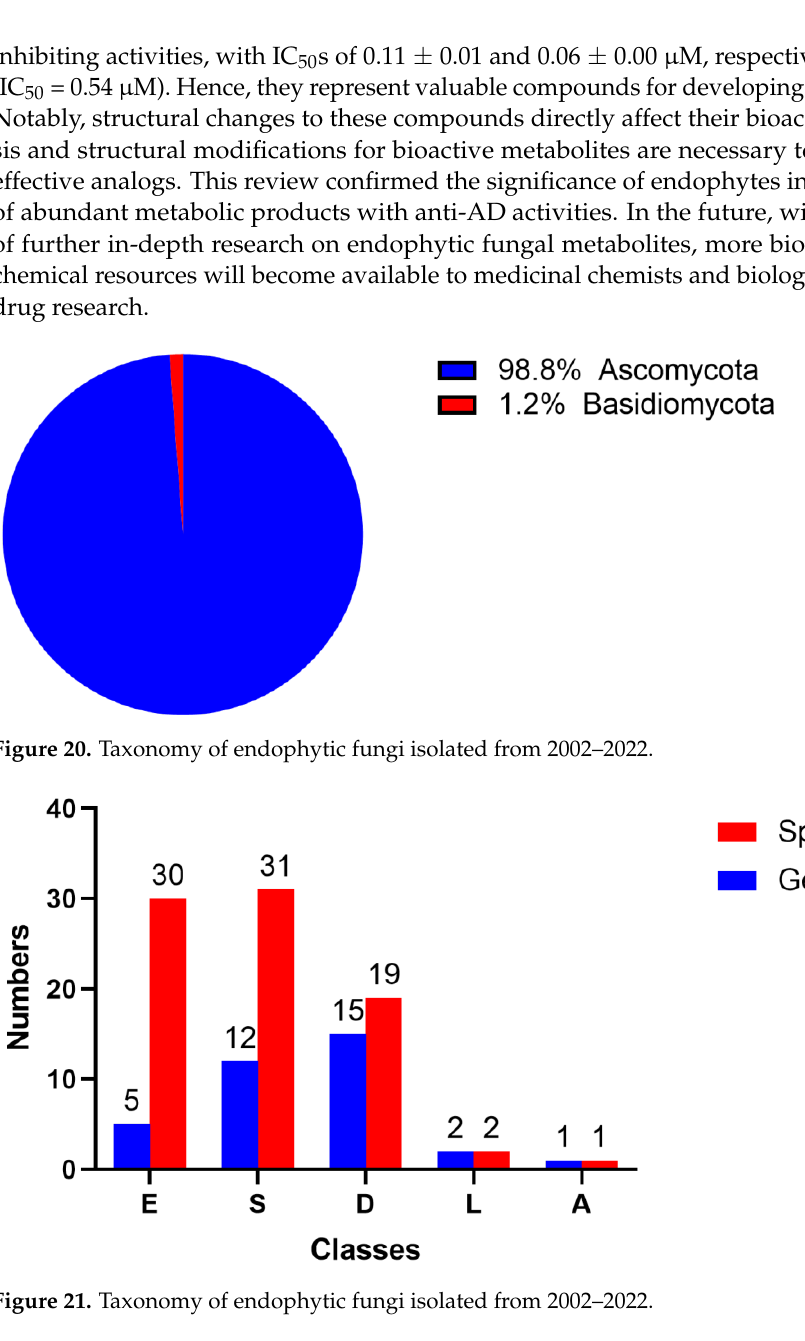
Table S3: Polyketides from endophytic fungi and their biological activities, metabolite class, fungus, host plant(s), reference; Table S4: Terpenes from endophytic fungi and their biological